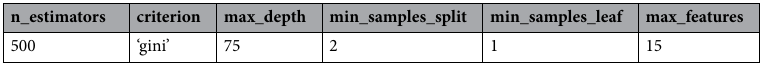
Table 1. Parameters considered in the compound-odor Random Forest